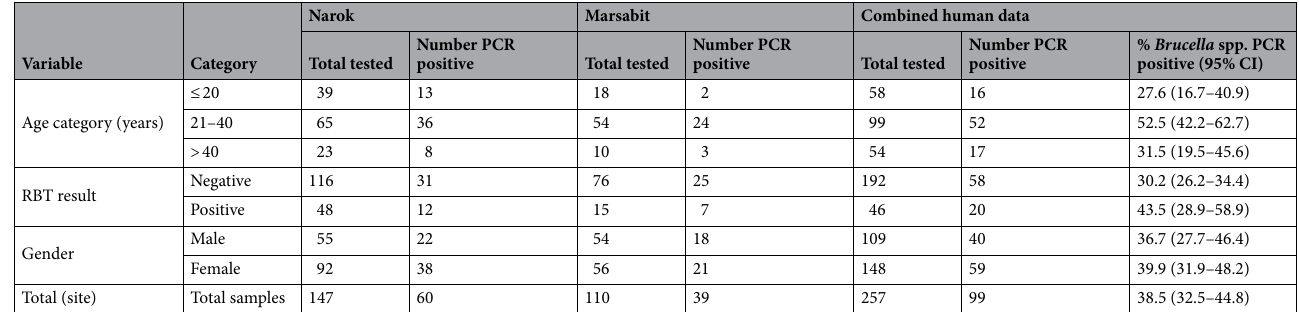
Table 2. Summary of human population descriptive, RBT results and Brucella spp. PCR results among suspected brucellosis patients referred for testing at the sampled medical facilities. PCR polymerase chain reaction, CI confidence interval, RBT Rose Bengal Test.